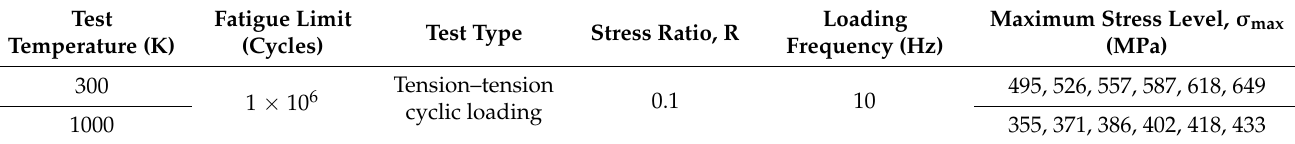
Table 2. Fatigue test conditions used in this study.